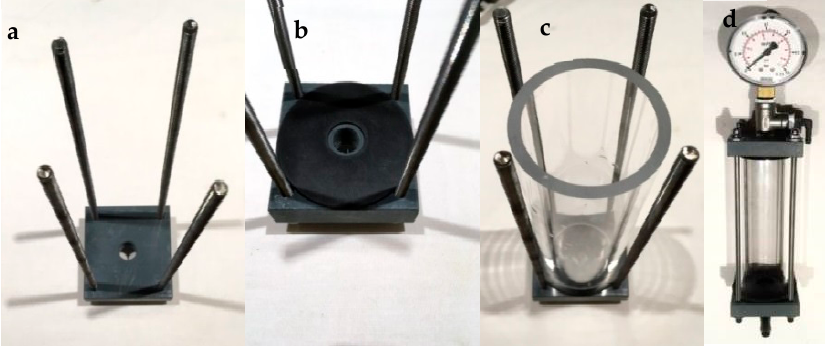
Figure A2. Reservoir assembly.